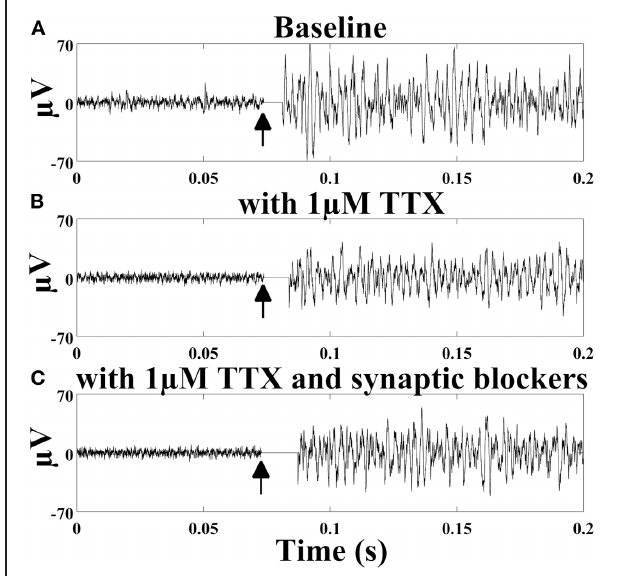
FIGURE 1 | Stimulus-induced high frequency oscillations. (A) SALPA filtered trace (sampling frequency 25kHz) from a single electrode in a hippocampal neuronal culture (age seven weeks) in medium, (B) medium with 1 μ M TTX, and (C) medium with 1 μ M TTX in addition to synaptic blockers CNQX (20 μ M), bicuculline (20 μ M), and APV (10 μ M). 0.5V stimulus occurs at the black arrow. Stimulation artifact removal by the SALPA algorithm blanks the trace for 2–5ms after the stimulus. Traces are representative: (A) and (B) (six cultures: two cortical and four